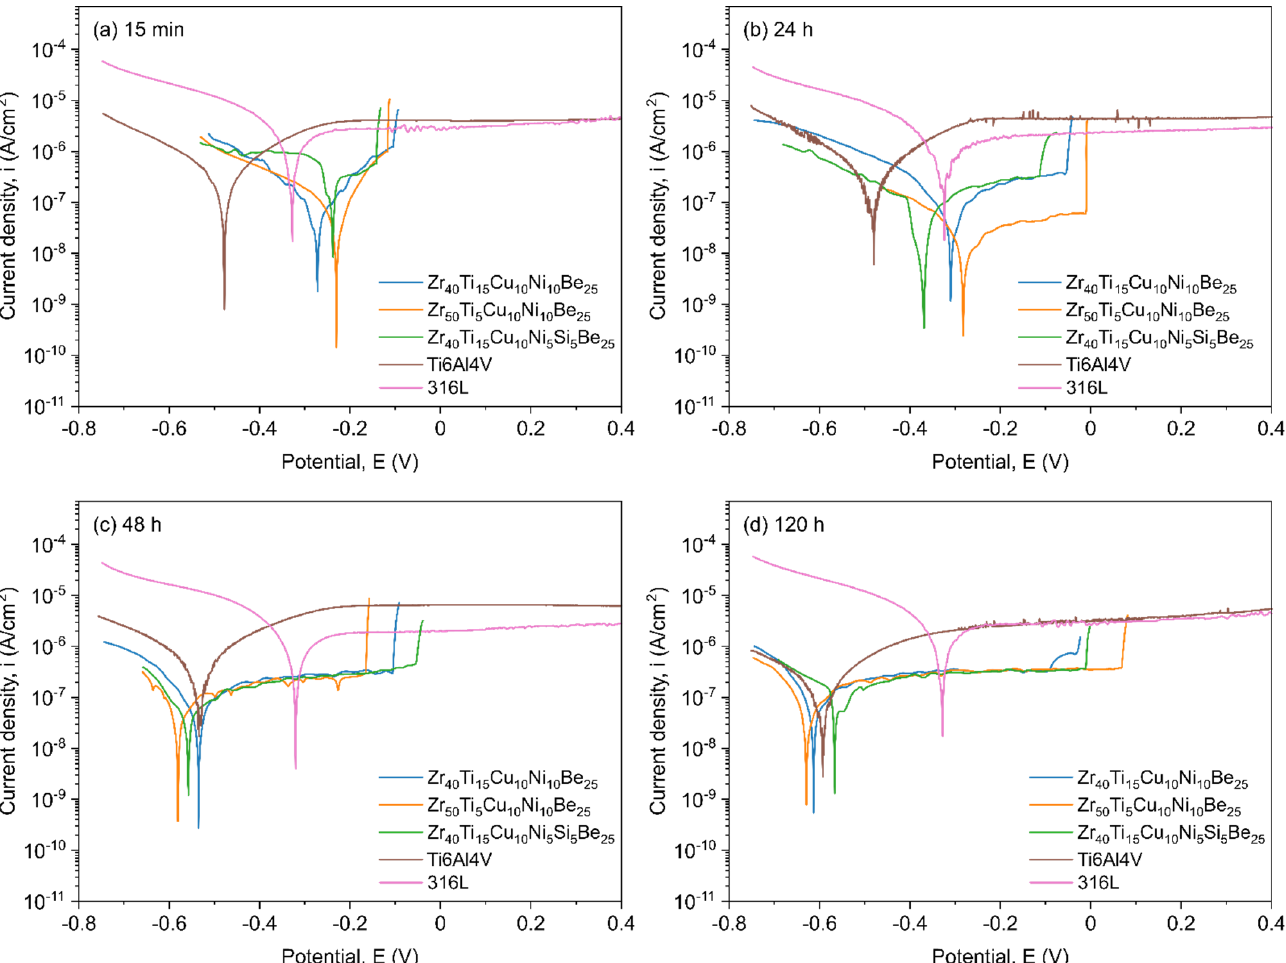
Figure 4. Potentiodynamic polarization curves for the produced Zr 40 Ti 15 Cu 10 Ni 10 Be 25 , Zr 50 Ti 5 Cu 10 Ni 10 Be 25 , and Zr 40 Ti 15 Cu 10 Ni 5 Si 5 Be 25 alloys, reference 316L steel, and Ti6Al4V alloy recorded after different times of exposition in SBF: ( a ) 15 min, ( b ) 24 h, ( c ) 48 h, and ( d ) 120 h.